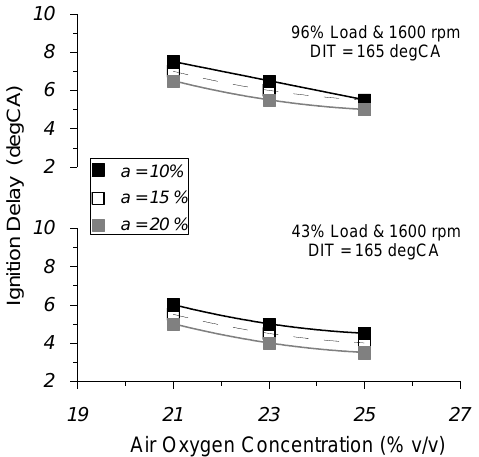
Figure 9. Calculated Ignition delay period versus “inlet-air oxygen ratio” for various “diesel fuel Figure 8. Calculated DoC versus “inlet-air oxygen ratio” for various “diesel fuel quantity ratios”, at quantity ratios”, at 43% and 96% of engine rated load and 1600 rpm engine speed, for DIT = 165 43% and 96% of engine rated load and 1600 rpm engine speed, for DIT = 165 degCA.